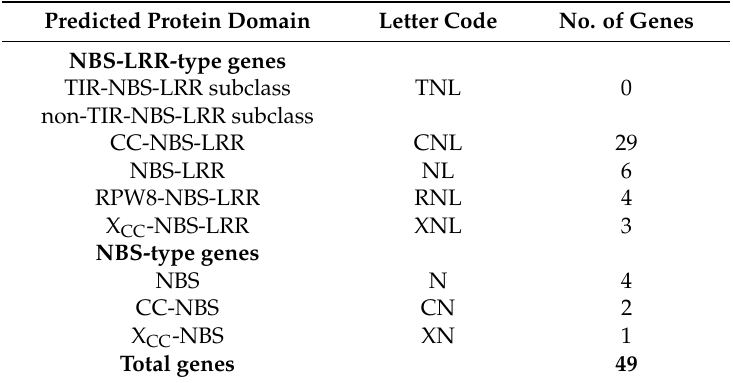
Table 1. Number and classification of NBS-encoding genes in the asparagus